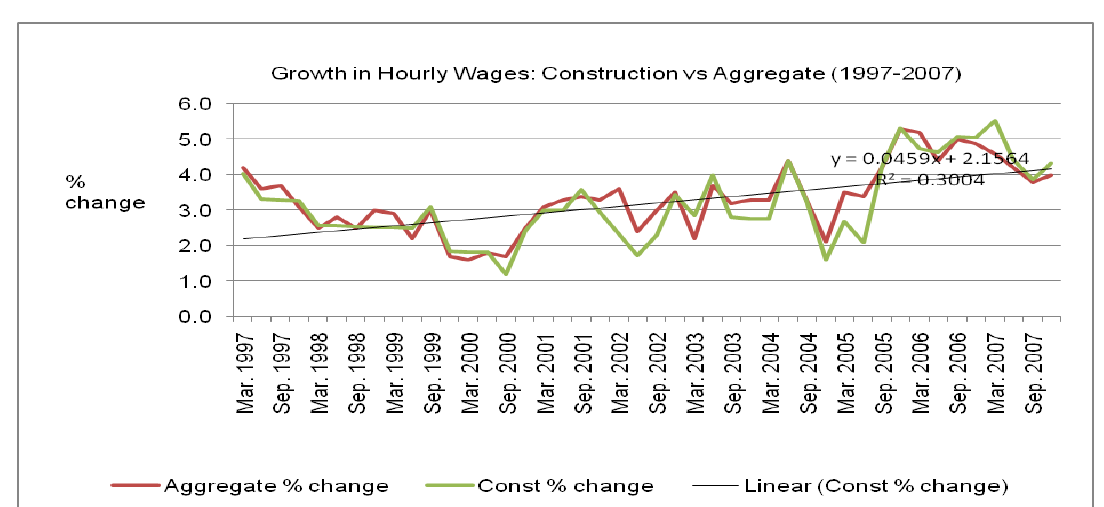
Figure 8 Growth in Hourly Wages: Construction v Aggregate (1988-2009)